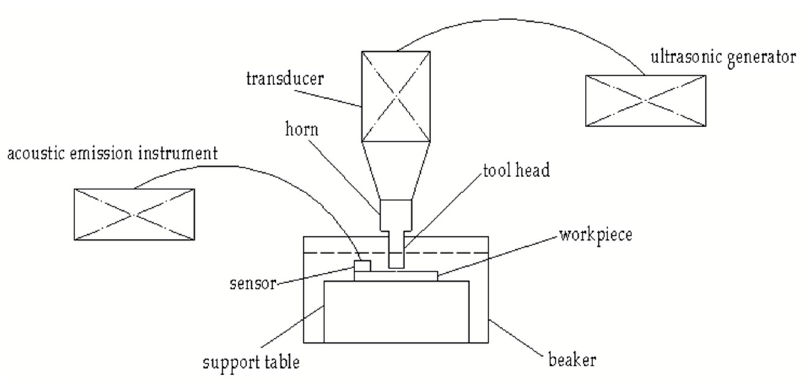
Figure 3. Schematic diagram experimental set-up.